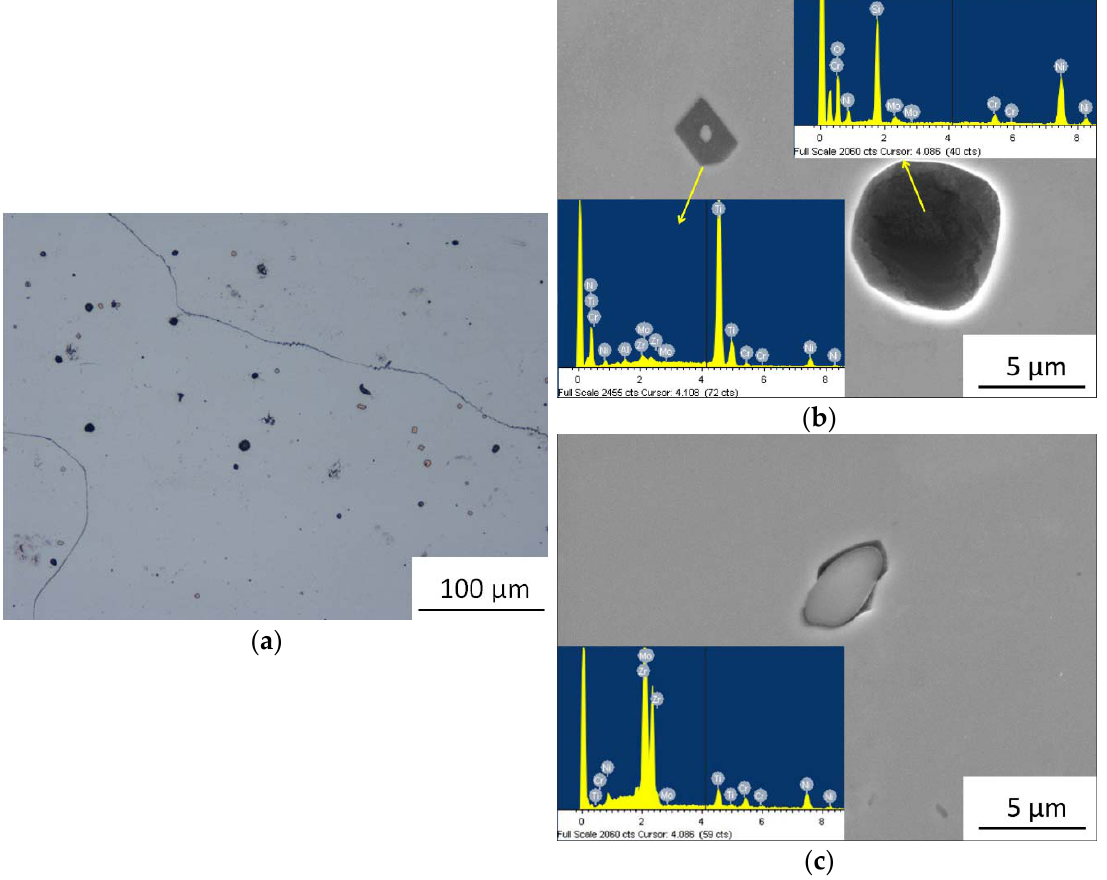
Figure 7. Microstructure of HN80MTY in the initial state: ( a ) light micrograph; ( b , c ) scanning electron micrographs.